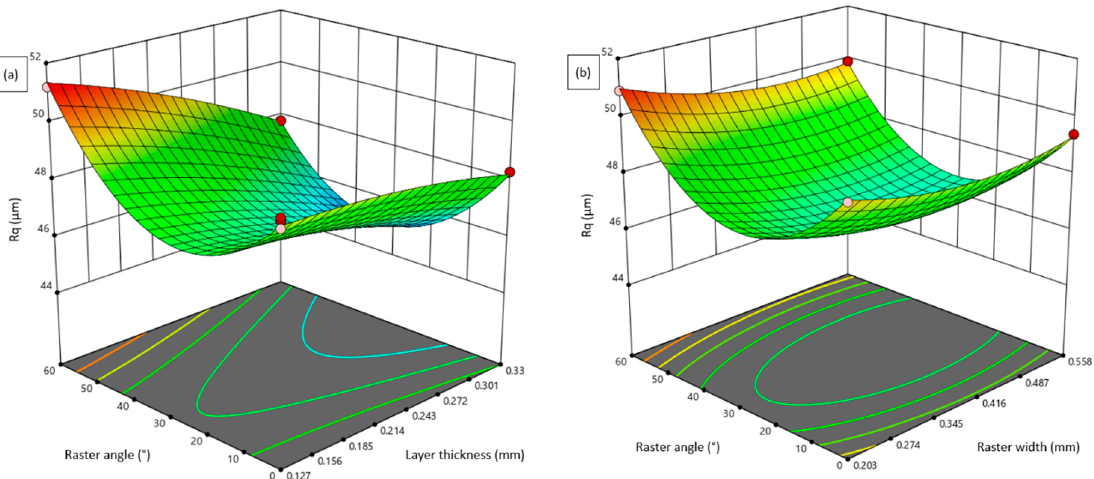
Figure 5. Influence of FDM parameters on Rq: ( a ) Layer thickness vs. Raster angle; and ( b ) Raster angle vs. Raster width